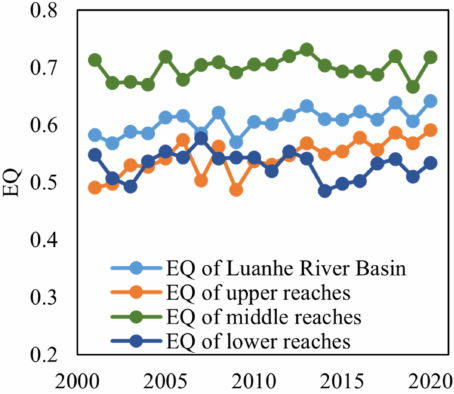
Figure 3. Time-series mean EQ of LHRB from 2001 to